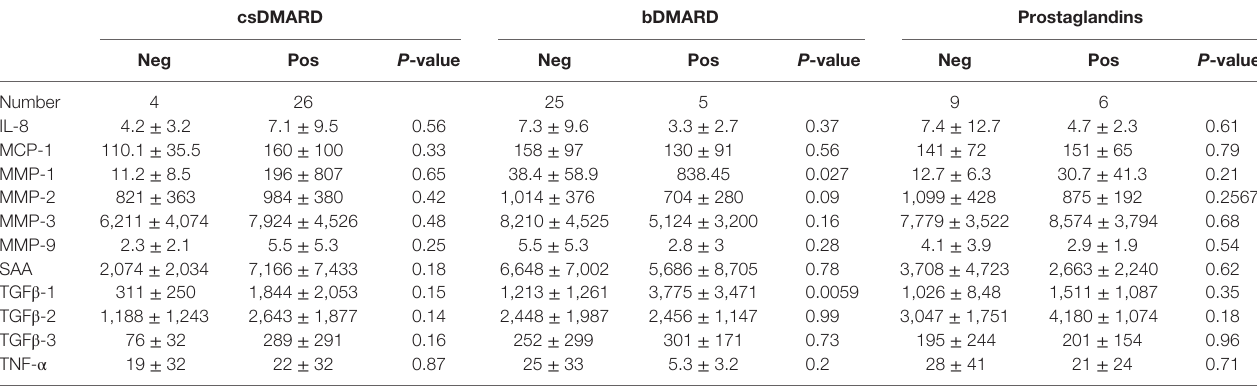
Table 4 | Influence of csDMARD, bDMARD, or prostaglandin medication on the expression of cytokines in the anterior chamber. csDMarD bDMarD